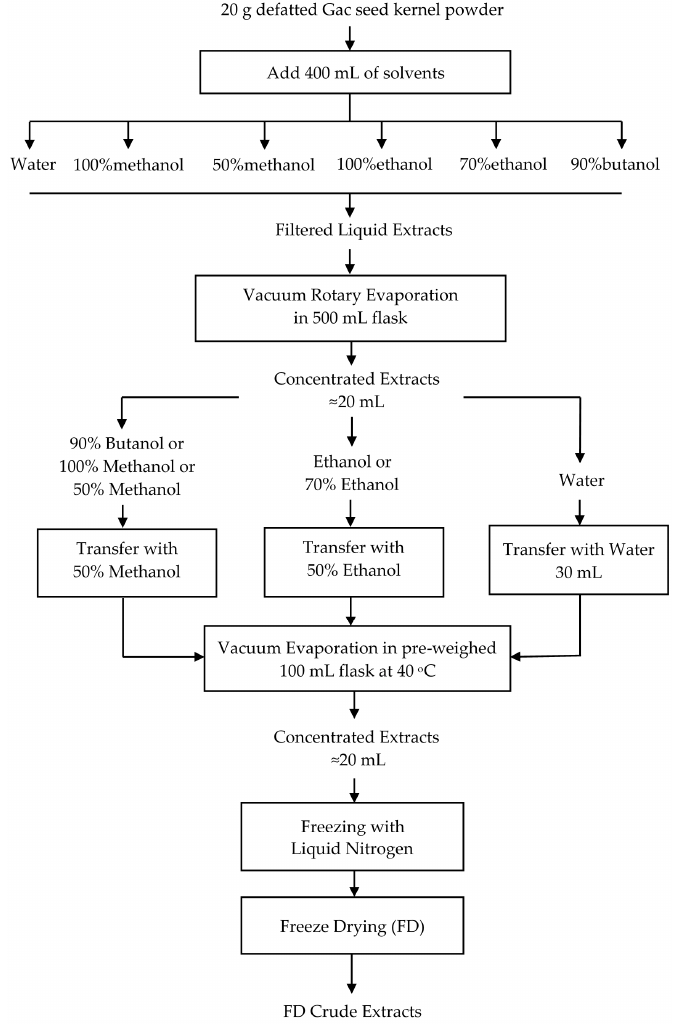
Figure 1. Procedure for producing freeze dried (FD) crude extracts from defatted Gac seed kernel